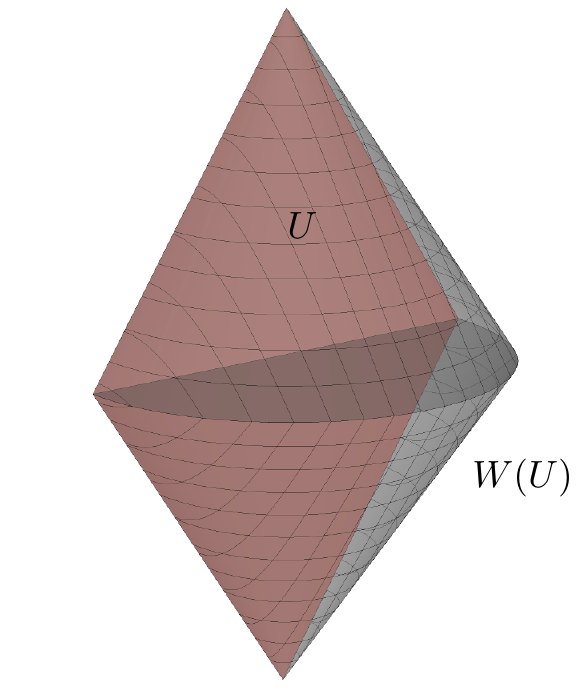
Figure 1 . The boundary domain of dependece U of a boundary segment at constant time, which is a diamond-shaped region, and its corresponding causal wedge W ( U ), which is a solid double